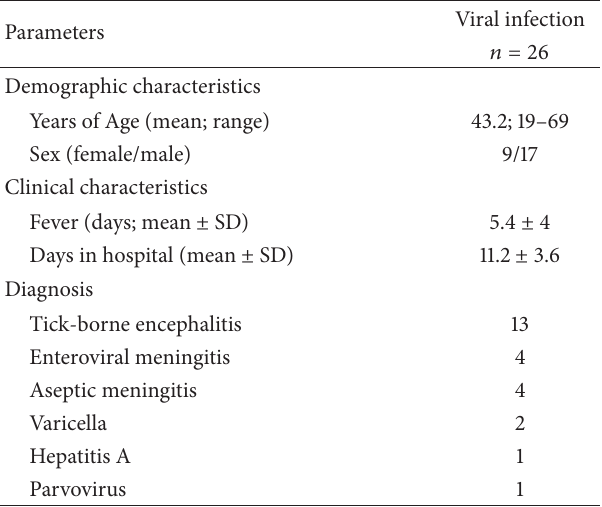
Table 2: Demographic and clinical characteristics of patients with viral